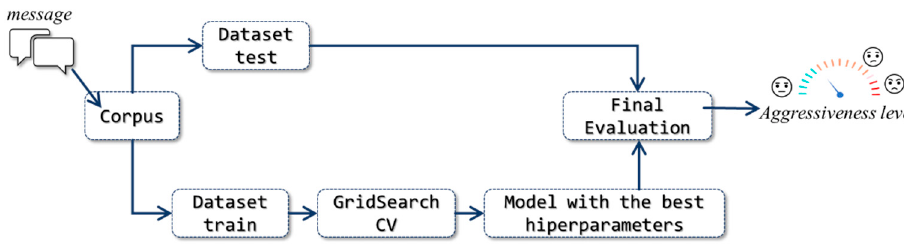
Figure 2. Training and testing process.